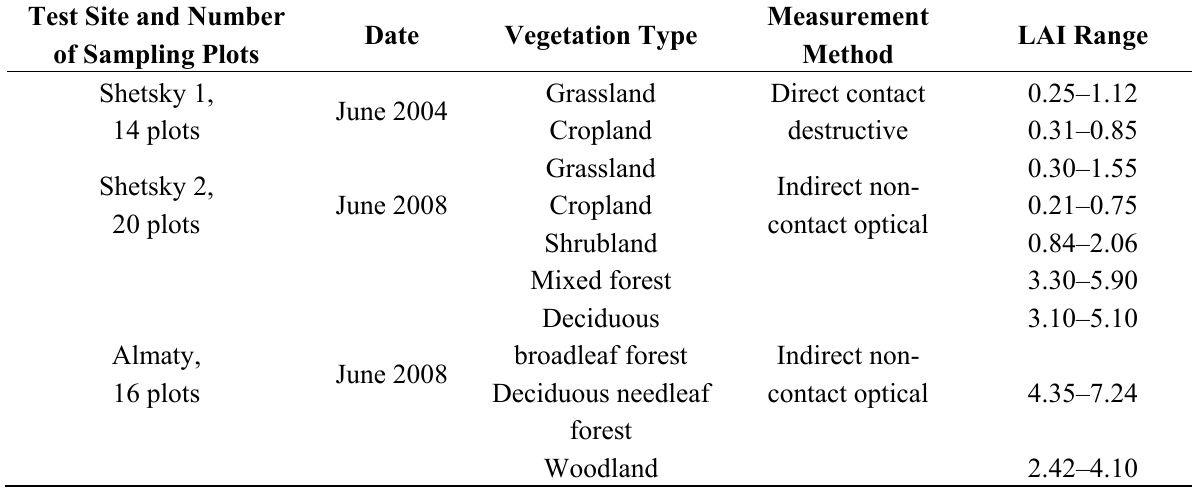
Table 1. In situ measurements of leaf area index (LAI) in Kazakhstan used in this study. For location of the test sites (see Figure